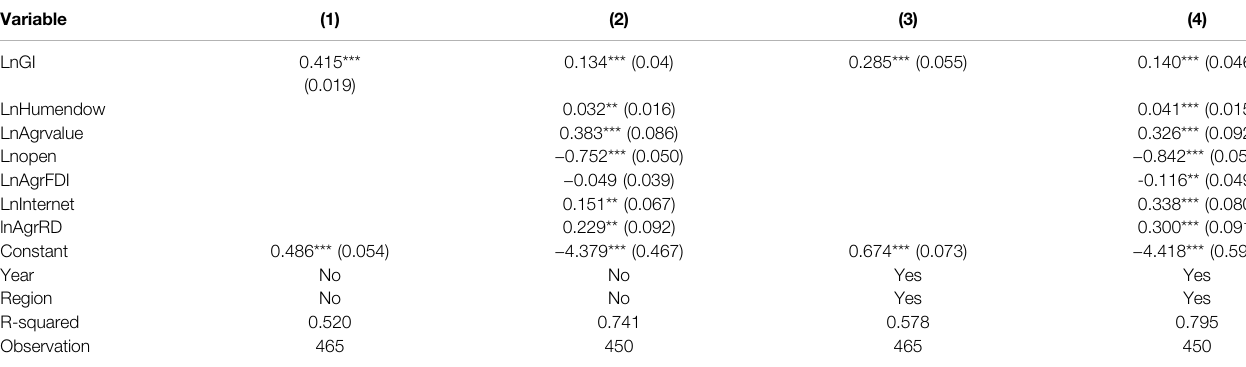
TABLE 2 | Benchmark regression of the impact of GIC on the technical complexity of export agricultural products.